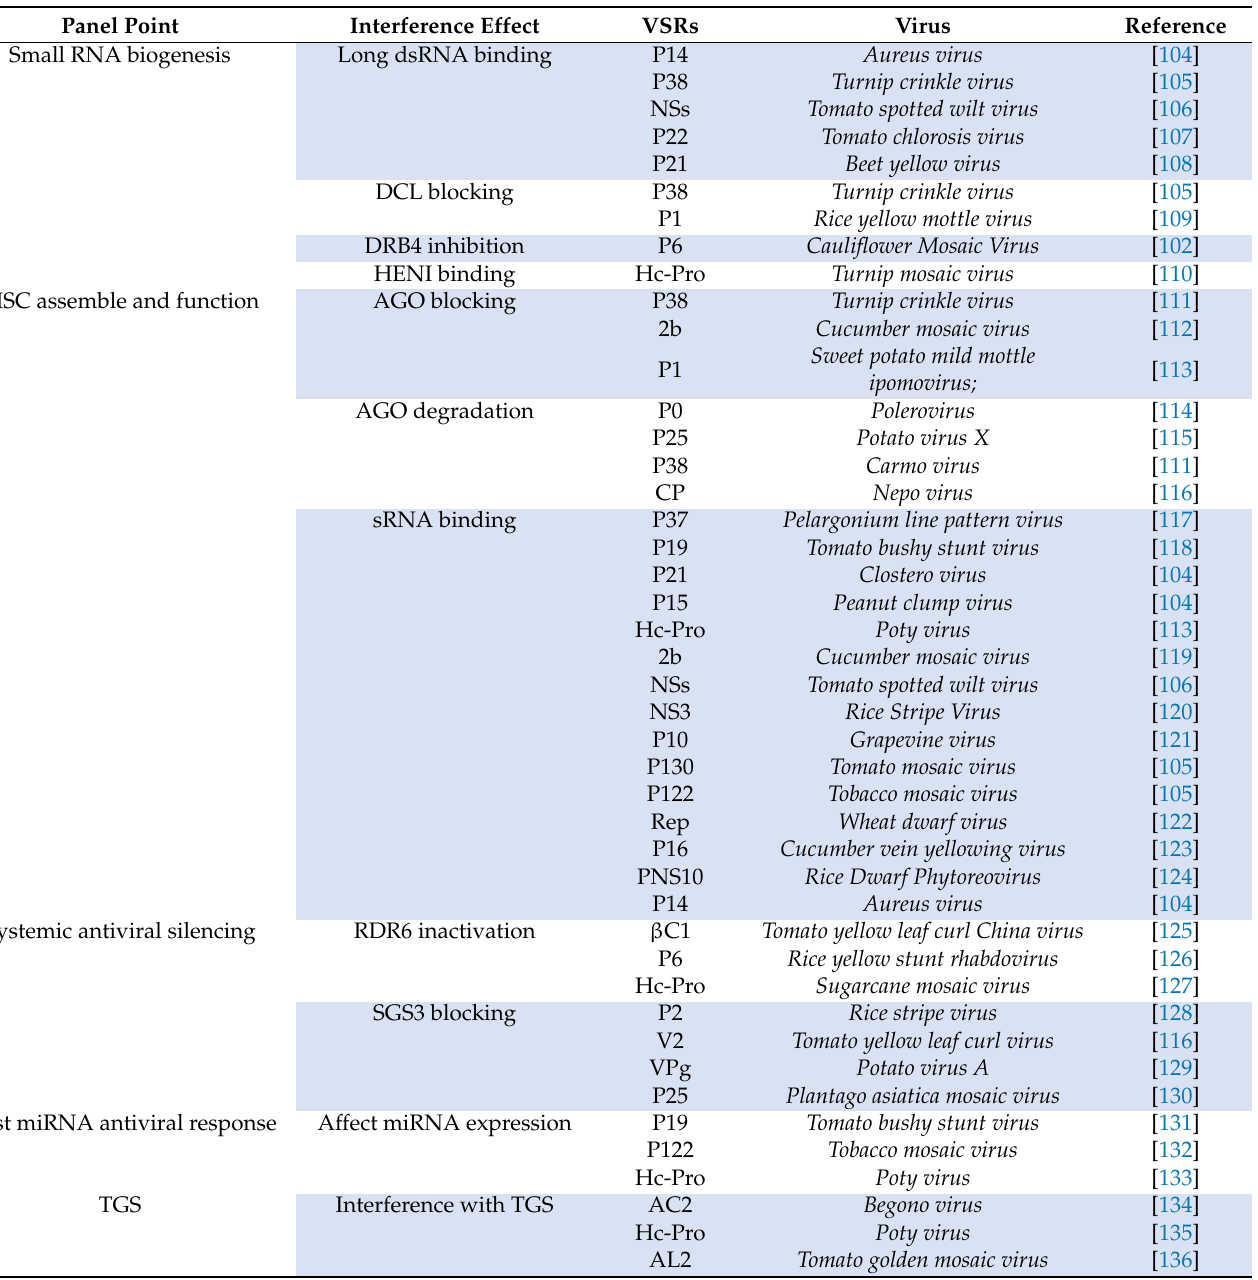
Table 1. A list of action sites of virus encoded RNA silencing suppressors interfering with host silencing